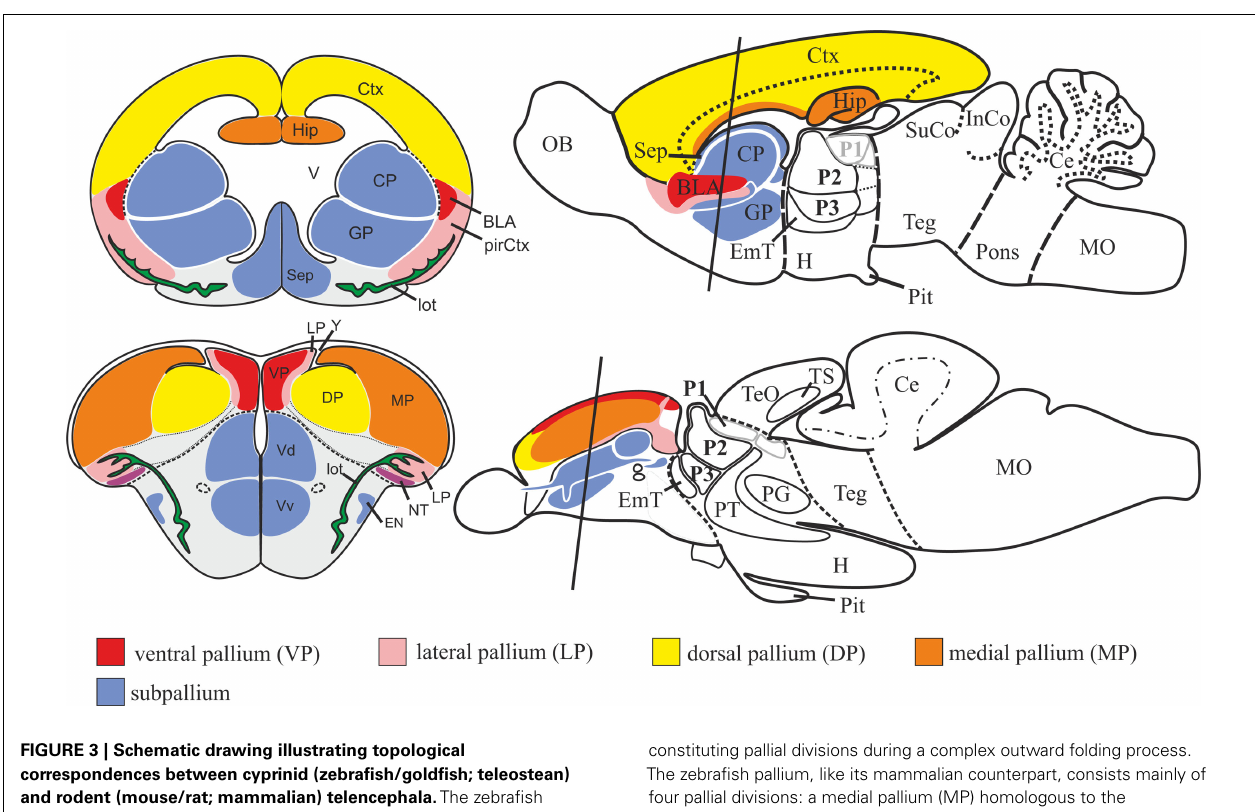
FIGURE 3 | Schematic drawing illustrating topological correspondences between cyprinid (zebrafish/goldfish; teleostean) and rodent (mouse/rat; mammalian) telencephala. The zebrafish telencephalon is characterized by two massive lobes covered by a dorsally located T -shaped ventricle.The mouse telencephalon, in contrast, consists of two bilateral hemispheres surrounding centrally located ventricles.The topology of the zebrafish pallium is similar to the one in mouse and can be explained through topographical shifts of its